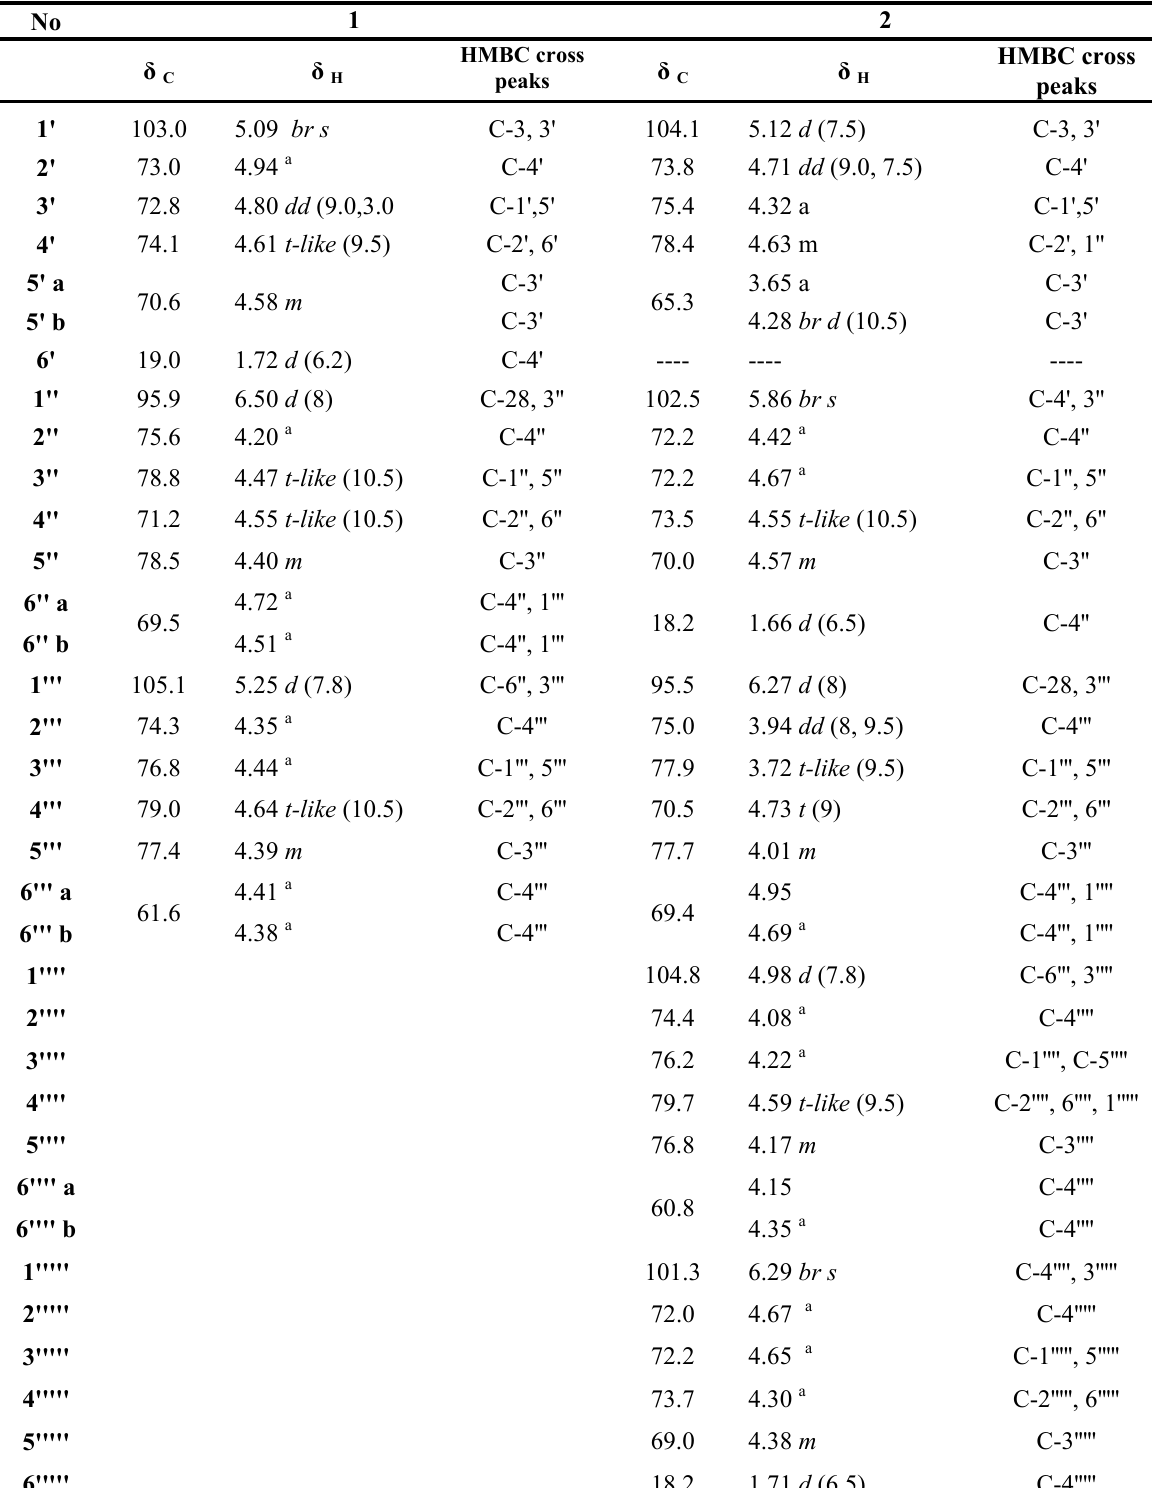
Table 2. 1 H-, 13 C-NMR and HMBC spectral data of sugar moieties in 1 and 2 ) (500/125 MHz, Pyridine- d 5